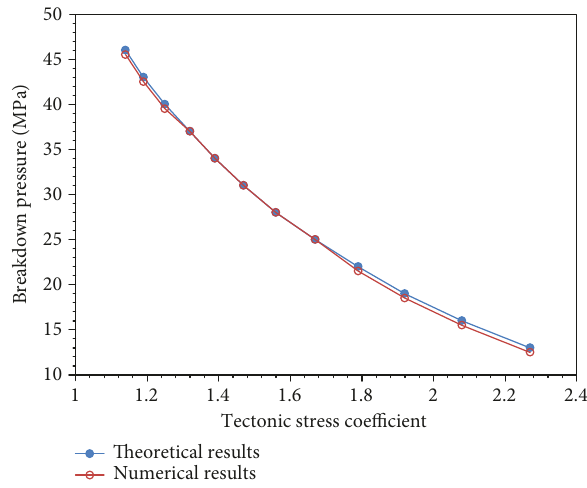
Figure 4: Comparison of the theoretical solution and numerical solution of breakdown pressure under di ff erent tectonic stress coe ffi